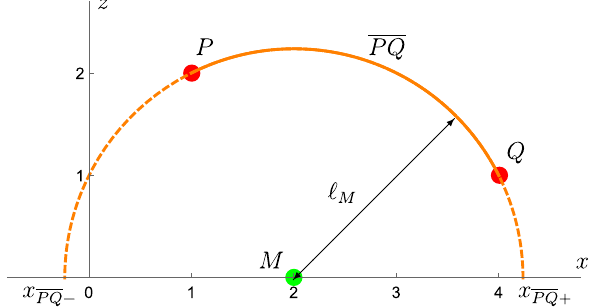
Fig. 6 Setup discussed in the main text, with two bulk points P and Q , shown in red, and the geodesic PQ that goes through them, shown in orange. The center of this geodesic is at M , shown in green, its radius is denoted by (cid:10) M , and its left and right endpoints are labeled x proper length of the arc running from P to Q (solid orange) defines the distance d ( P , Q ) , given explicitly in